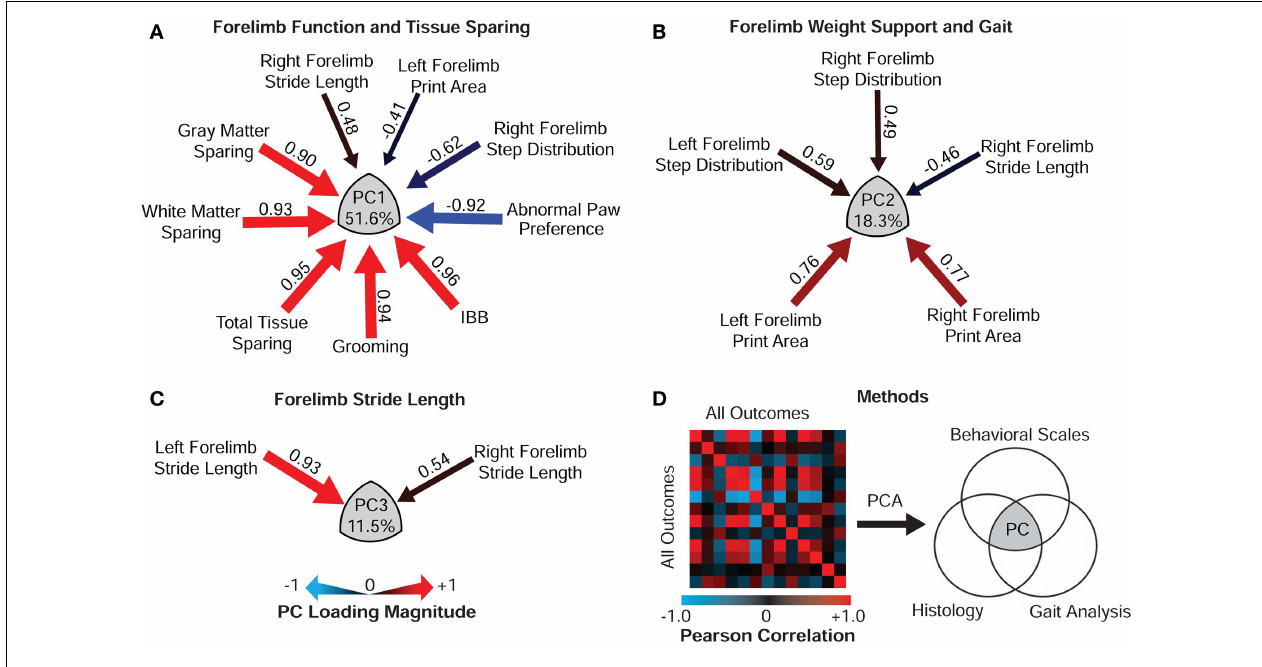
(C) PC3 (11.5% variance) reflects forelimb stride length. (D) PCA extracts the PCs through eigenvalue decomposition of the bivariate correlation matrix of all outcomes, here represented as a heat map of Pearson values. PCs are reflected as theVenn intersection (gray) across outcome domains and the PC loading values (correlation between each variable and the PC cluster) are represented as arrows where gage represents loading magnitude and heat reflects direction (red positive relationship, blue inverse